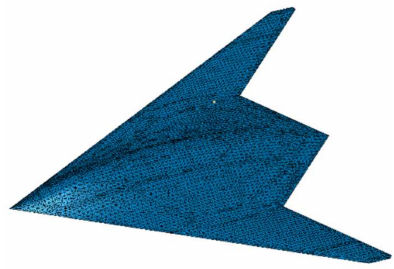
Figure 3. The grid of a stealth